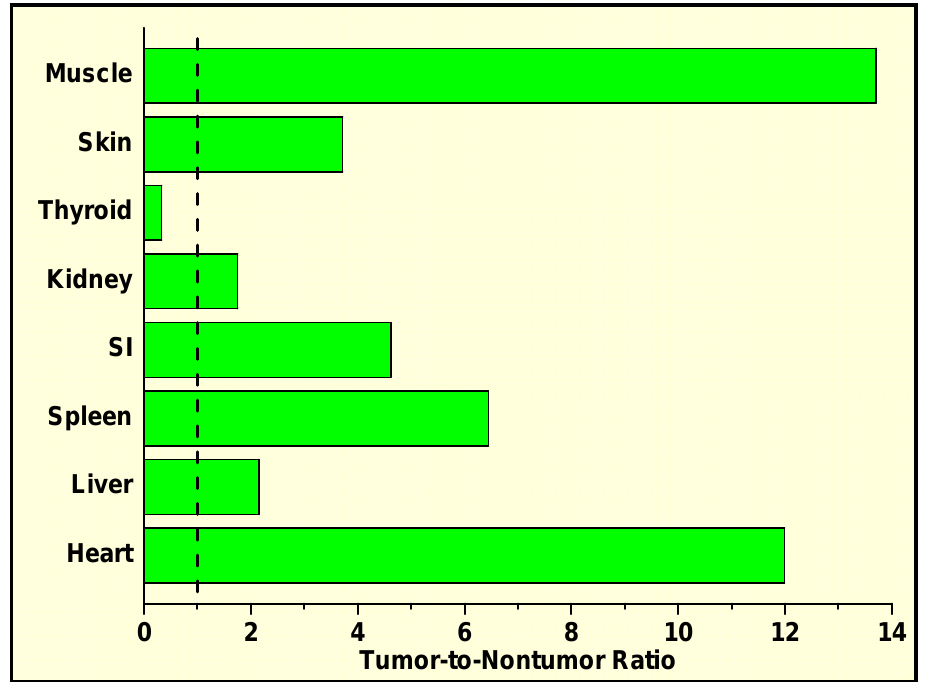
Figure 7. T/NT ratios in mice bearing i.p. OVCAR-3 tumors and injected i.p. 24 h earlier with 125 IQ 2–P